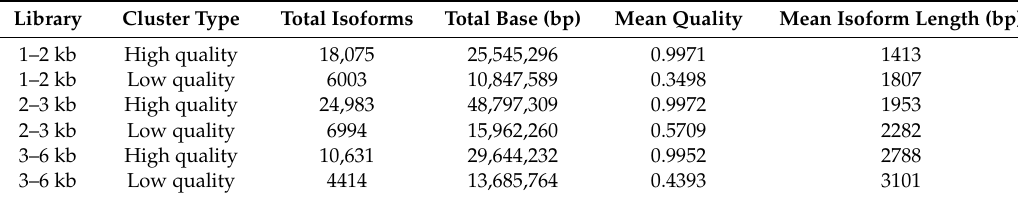
Table 2. Cluster summary for each library.